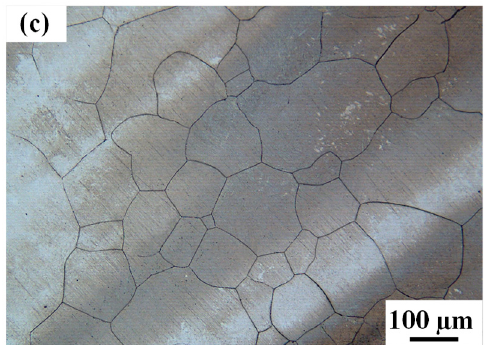
Figure 2. Optical micrograph of prior austenite grain at different austenitizing temperatures: ( a ) 880 °C; ( b ) 1020 °C; and ( c ) 1200 °C.